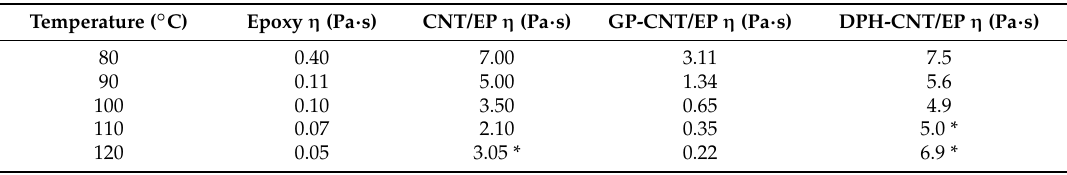
Table 4. Measured viscosity η * [Pa s] at different temperatures for pristine epoxy resin and filled